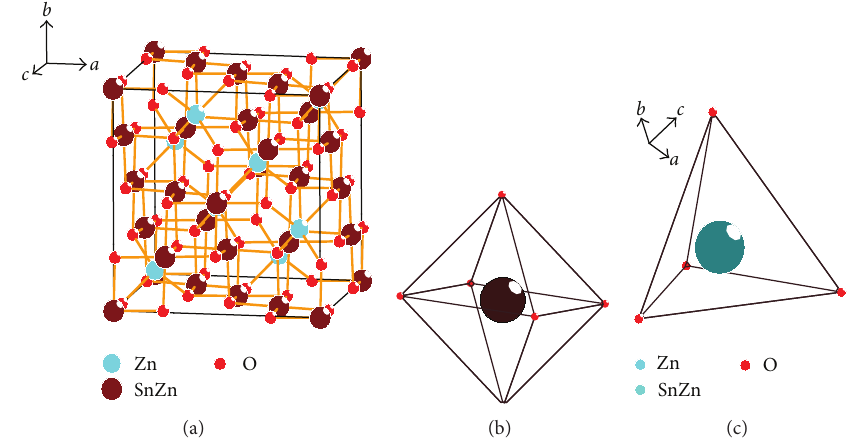
Figure 6: (a): Schematic representation of the crystal structure of “inverse spinel” Zn 2 SnO 4 . (b) Octahedrally coordinated “SnZn” cation. (c) Tetrahedrally coordinated Zn atom.